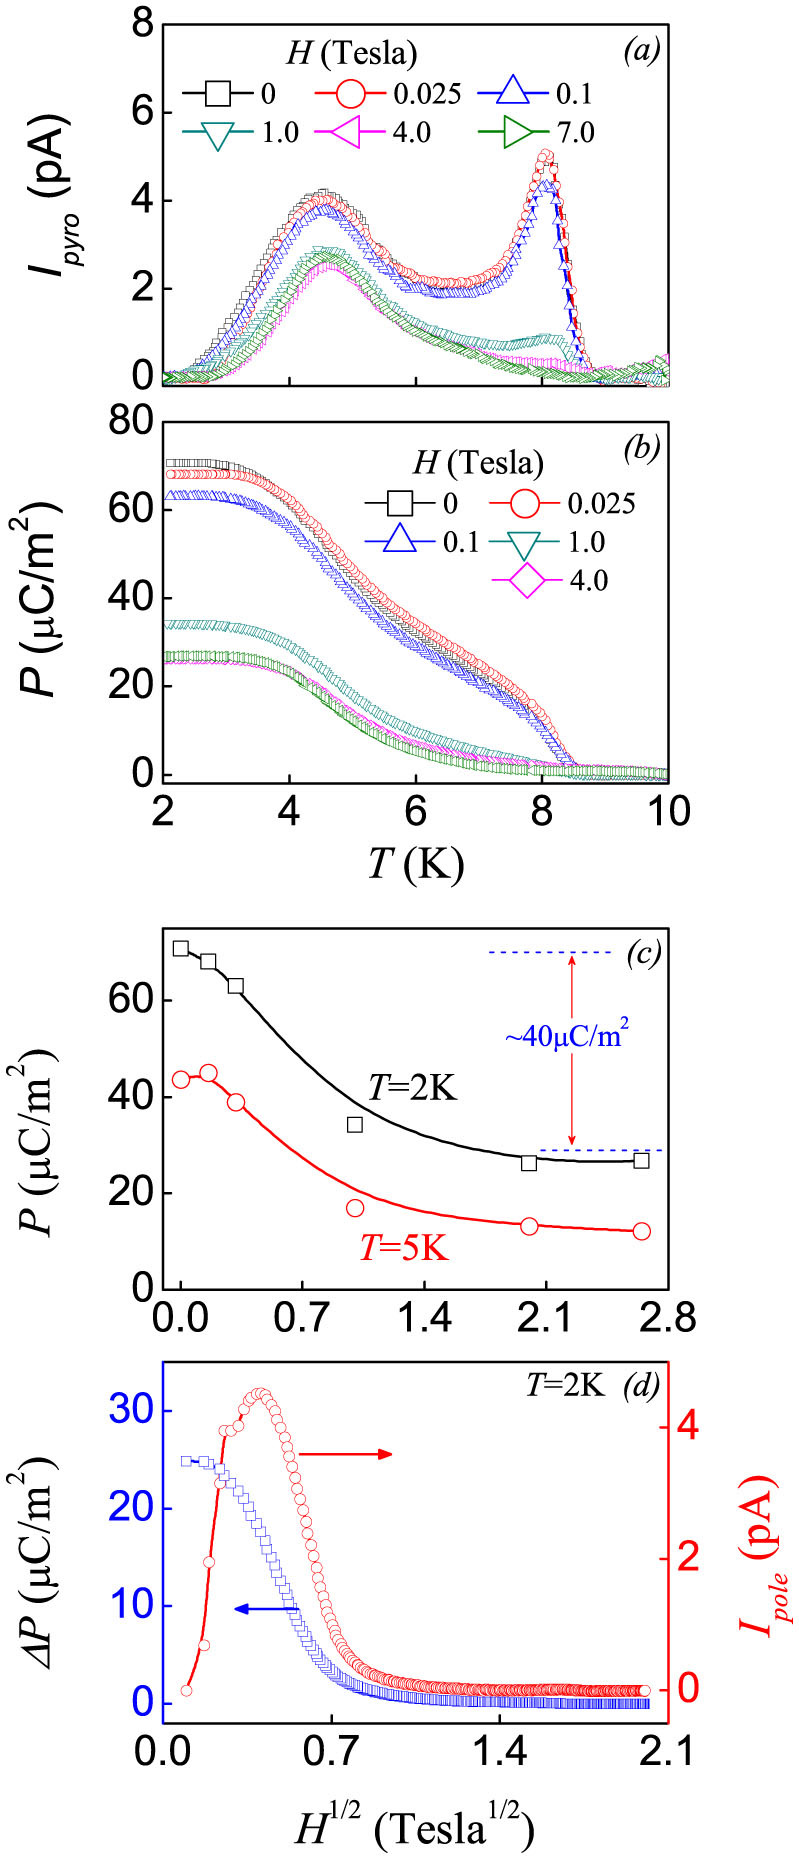
Measured Ipyro-T data (a) and P-T data (b) under various magnetic fields. (c) Evaluated P-H relations under T = 2 K and 5 K. (d) Measured Ipole-H and ΔP-H data at T = 2 K with scanning magnetic field rate 100 Oe/s.